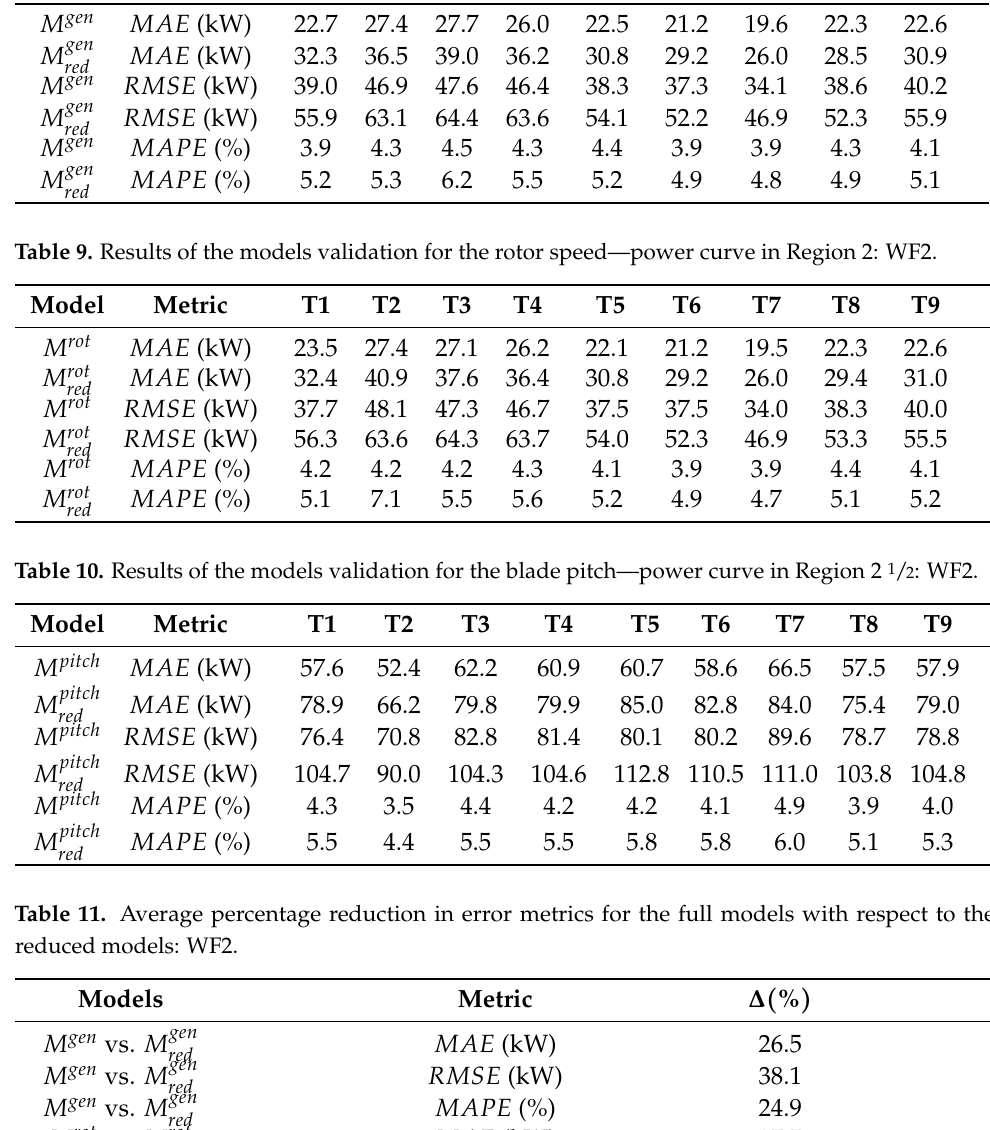
Table 8. Results of the models validation for the generator speed—power curve in Region 2: WF2. Model